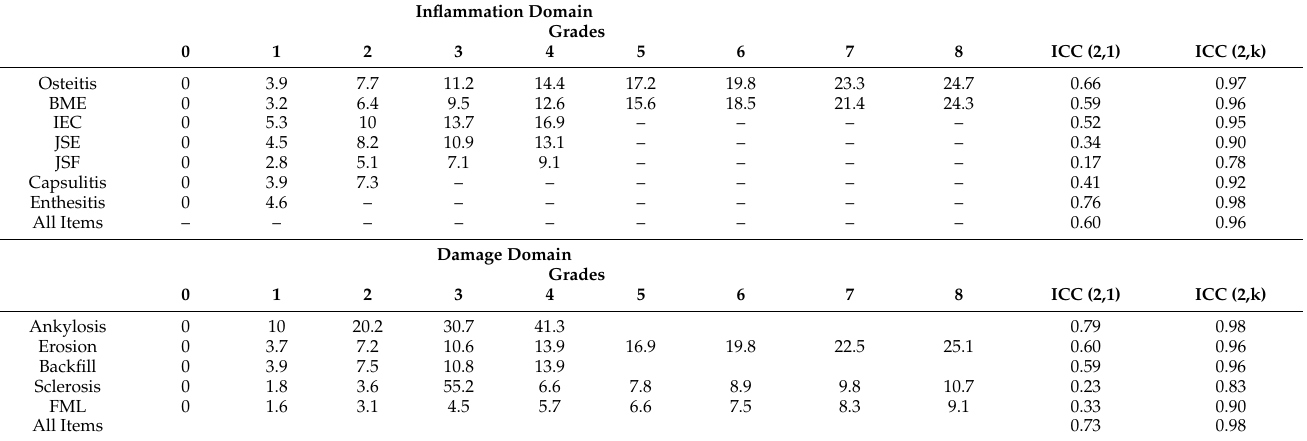
Table 1. Conjoint analysis survey-derived relative percentage weight for the measurement compo- nents of the JAMRIS-SIJ. Following the grading of an image, the percentage weight of each component grade was added to constitute the domain percentage disease severity score ranging from 0–100% for seven inflammation and five damage domain items, respectively. The percentage weights are reported as group means relative weights. BME; bone marrow edema, IEC; inflammation in erosion cavity, JSE; joint space enhancement, JSF; joint space fluid, FML; fat metaplasia lesion. ICC: intraclass correlation